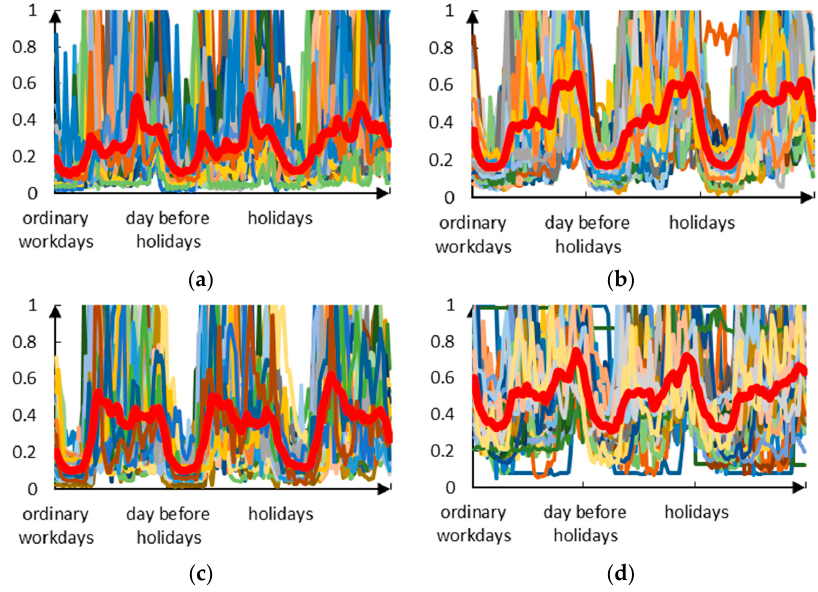
Figure 9. The effect pictures as the number of clusters is four. ( a ) The first cluster; ( b ) The second cluster; ( c ) The third cluster; ( d ) The fourth cluster.